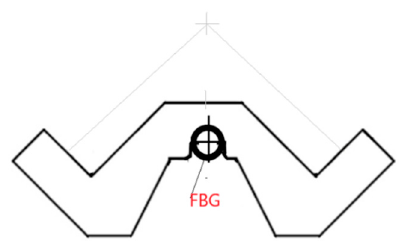
Figure 4. Designed grips for the fixing of FBG SC-01 and SC-02 sensors.